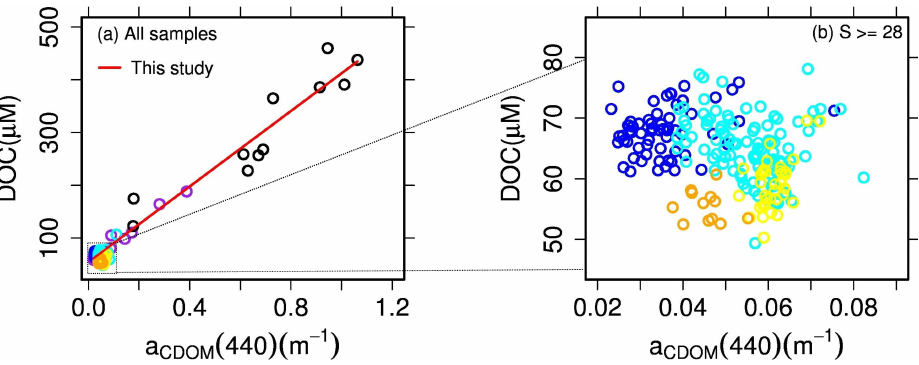
Fig. 9. Relationship between DOC and a CDOM (440) for (a) the whole salinity range and (b) salinity ≥ 28 (below the UPML). See Fig. 5 for symbols. A linear fit provides the following relationship: DOC = 55 + 357*a CDOM (440) ( r 2 = 0 . 97; p < 0 . 0001).